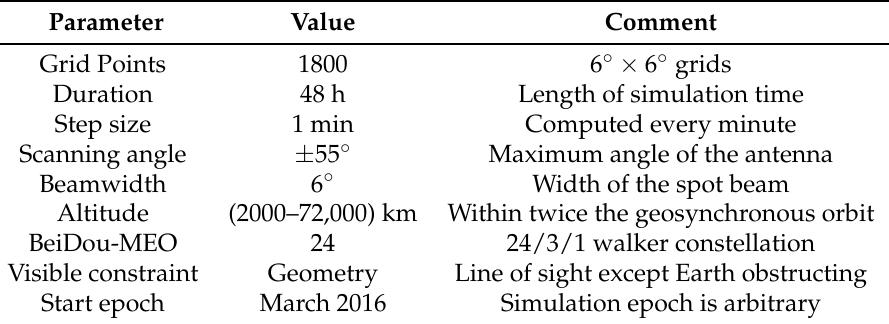
Table 1. Parameters used in the numerical simulation.